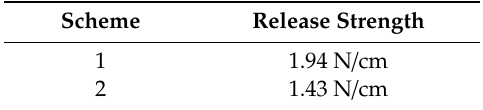
Table 5. Release strength under different process conditions.